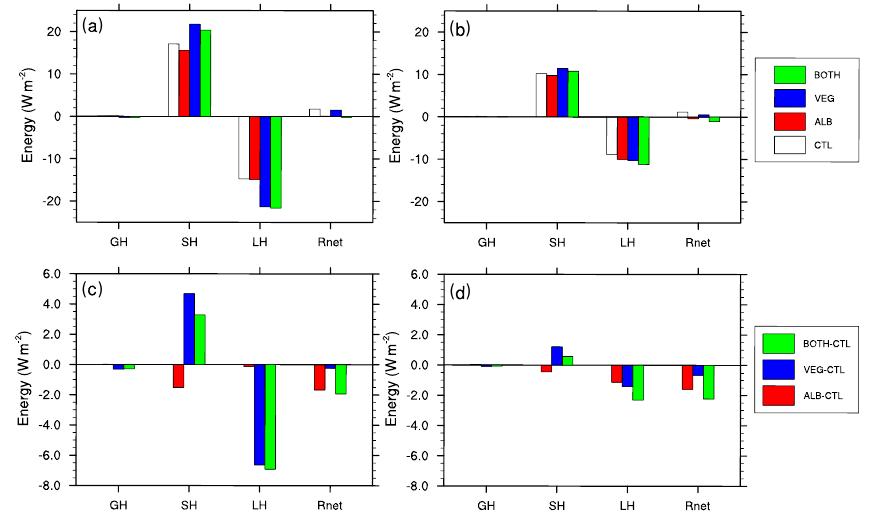
Figure 12. The change in surface energy budget terms (ground heat – GH, sensible heat – SH, latent heat – LH, net radiation – R net ) between drought and pre-drought years. Panels (a) and (b) show the 2002–2000 change and 2006–2005 change, respectively, for each simulation experiment. Panels (c) and (d) show the difference between each experiment and the control simulation for the 2002–2000 change and the 2006–2005 change,